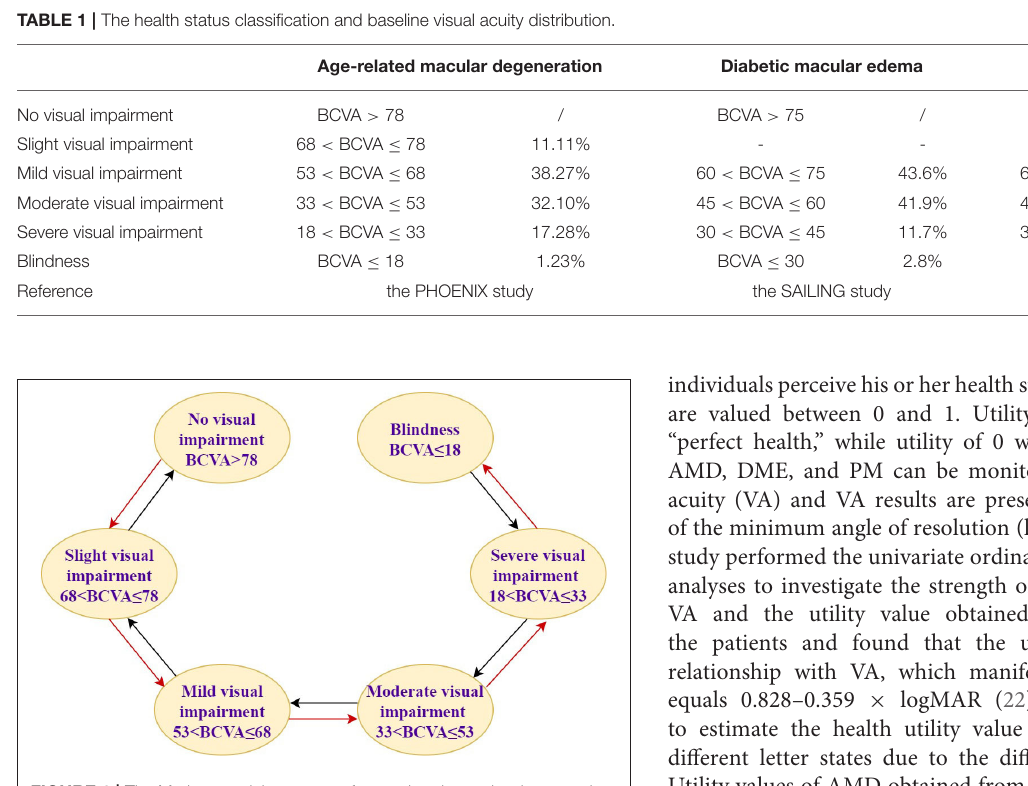
FIGURE 1 | The Markov model structure of age-related macular